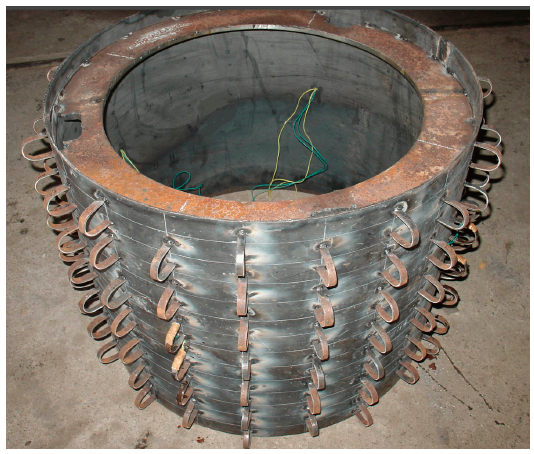
Figure 2. Anchor clamps welded onto the surface of the inner steel